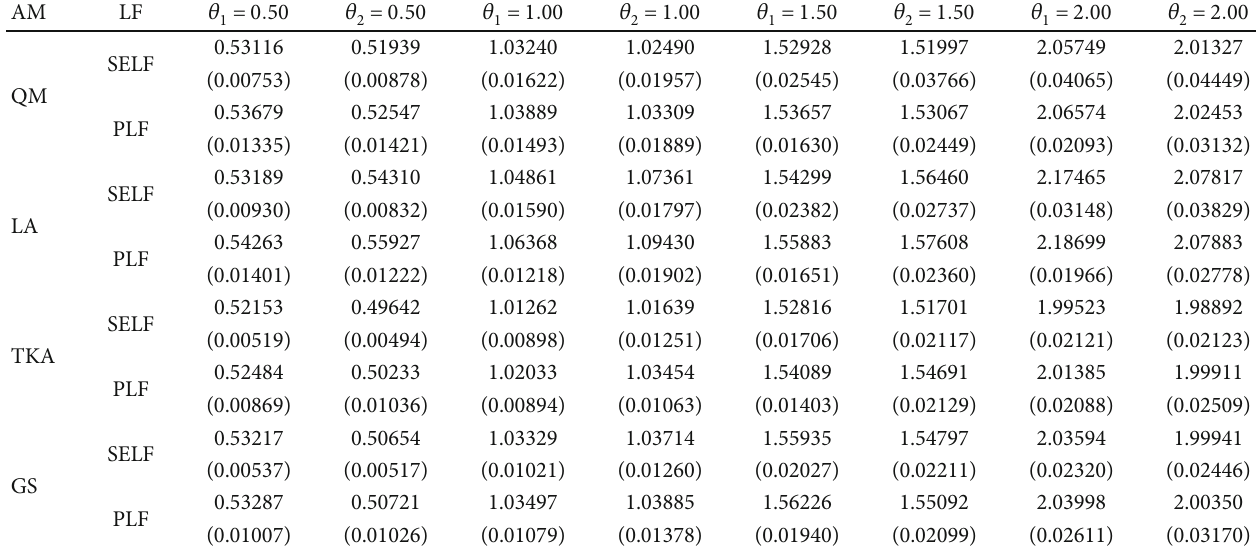
Table 4: BEs and PRs (in parentheses) under IP for n = 100 .